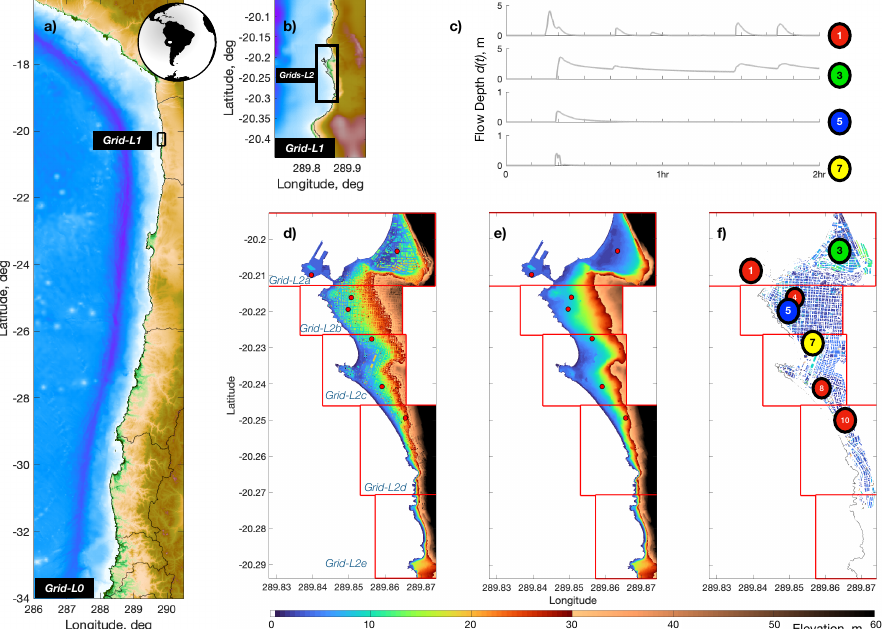
Figure 1. Location of the area of interest and coverage of the numerical grids. ( a ) Outermost domain, Level-0; ( b ) Intermediate domain, Level-1; ( c ) Time series at gauges of interest; ( d – f ) Five different Level-2 grids, shown as ( d ) DSM, ( e ) DTM, and ( f ) the difference between DSM and DTM. In ( d – f ), the difference in color maps is at 30 m elevation. Colored dots denote the location of the inland gauges. These colors are retained in all figures to identify each inland gauge. Table 1. Vectors of the ratio of grid resolution tested.